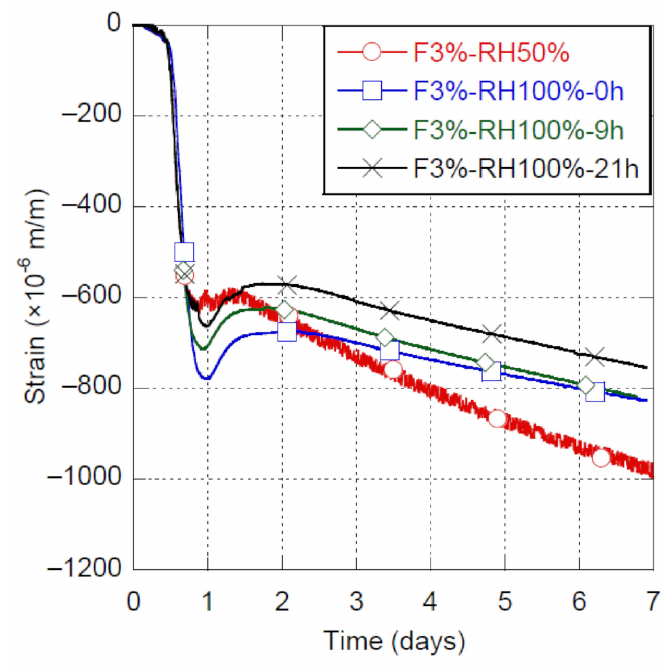
Figure 4. Shrinkage of UHPC-F3% with RH100% started at 0, 9 and 21